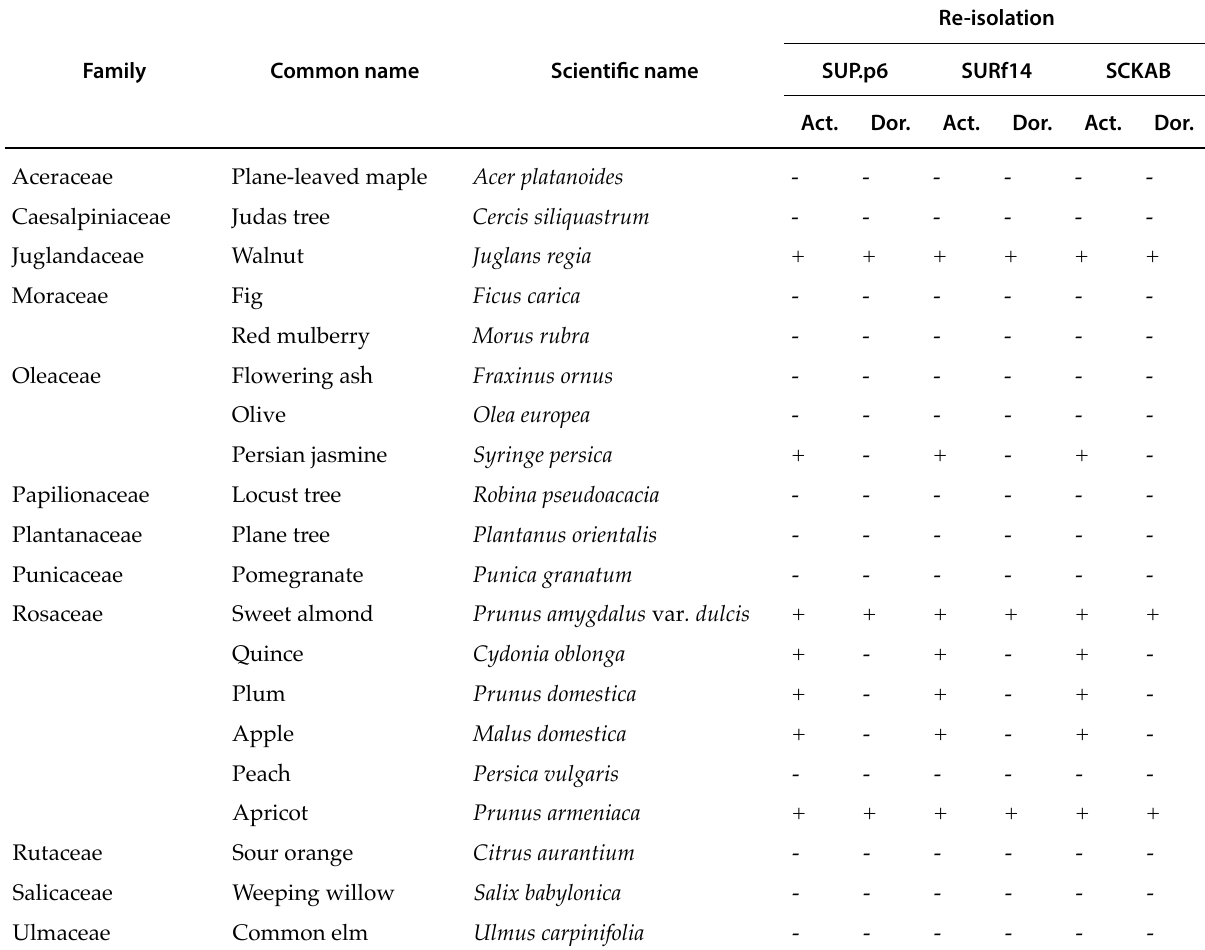
Table 3. Susceptibility detached tree twigs to Phytophthora pistaciae isolates tested in active (Act.) or dormant growth stage